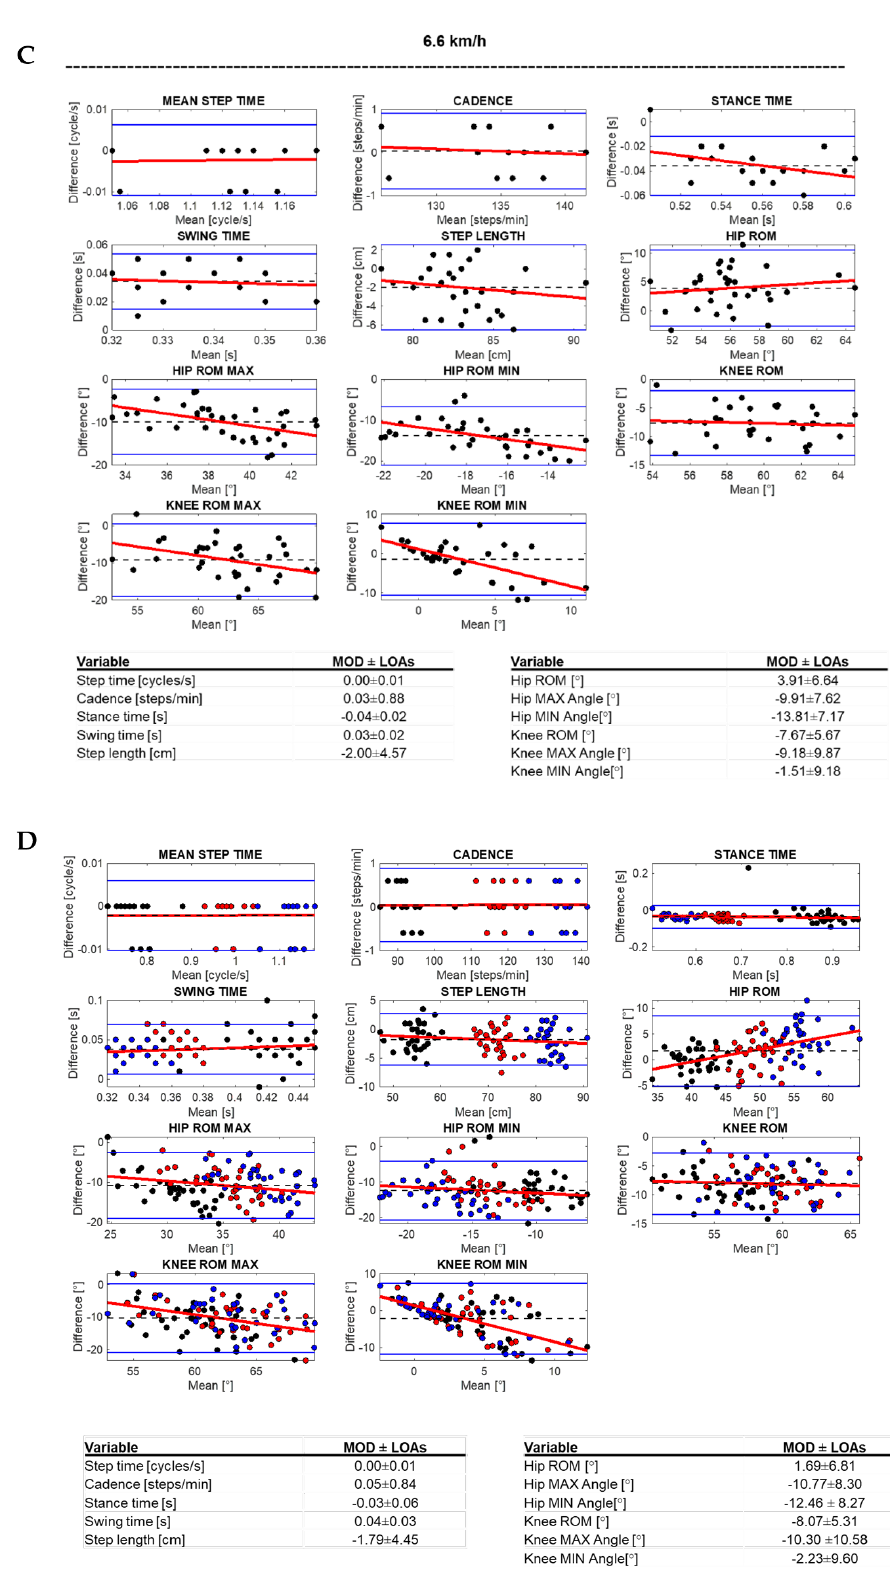
Figure 6. Bland–Altman plots related to the spatiotemporal and kinematical variables recorded from all the volunteers at 3 km/h ( A ), 5 km/h ( B ), and 6.6 km/h ( C ). In the plots, the black dashed line represents the mean of difference (MOD), blue lines represent the limits of agreement (LOA), and red lines show regression line of the difference on means. ( D ) Aggregate values of the three walking speeds: black dots for 3 km/h, red dots for 5 km/h, and blue dots for 6.6 km/h. Below, the tables summarizing the MOD and LOA